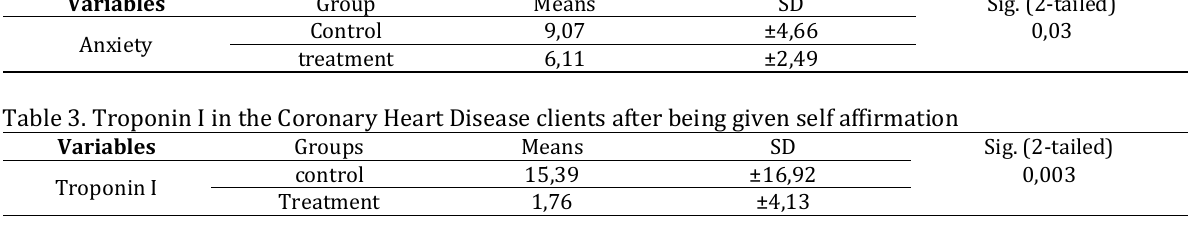
Table 4. LDH value in the coronary heart disease clients after being given self affirmation